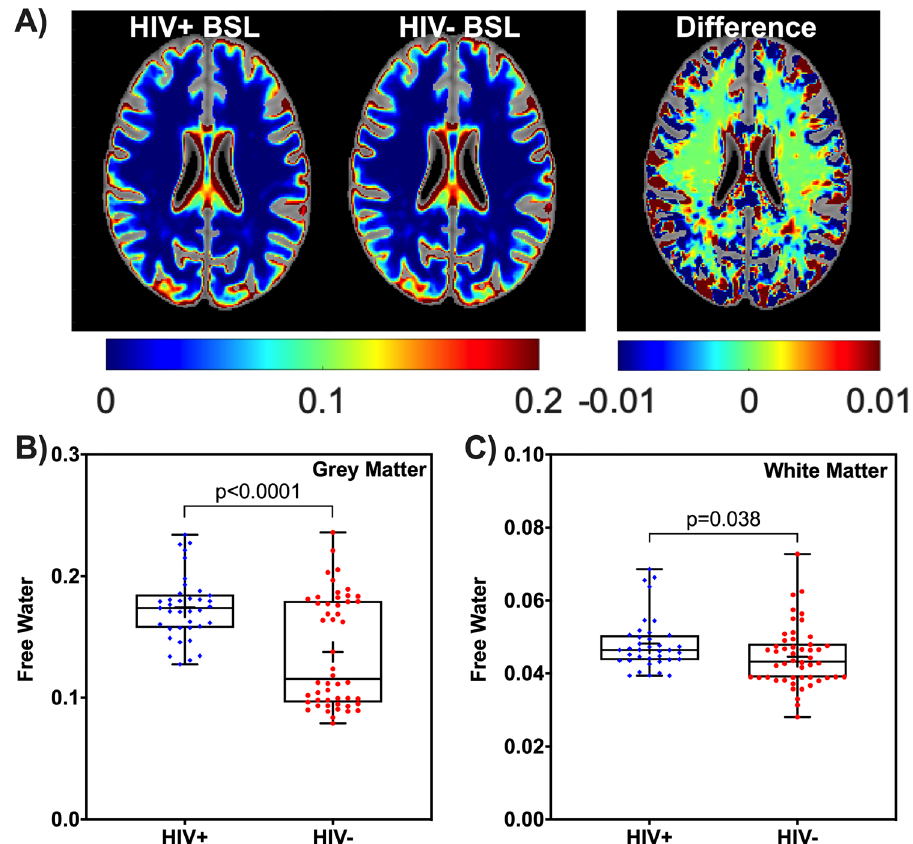
Figure 1. Baseline free water comparison for HIV+ and HIV− cohorts. ( A ) Mean free water (FW) maps (axial view) from 37 HIV+ participants and 52 HIV− participants, and the corresponding difference map at baseline are shown with intensity scales. The box-and-whisker plots illustrate the comparison of the FW index between the HIV+ and HIV− at baseline for ( B ) grey matter (GM) and ( C ) white matter (WM); Note significant differences are shown; + sign in the box plots indicates mean FW of each cohort. BSL,